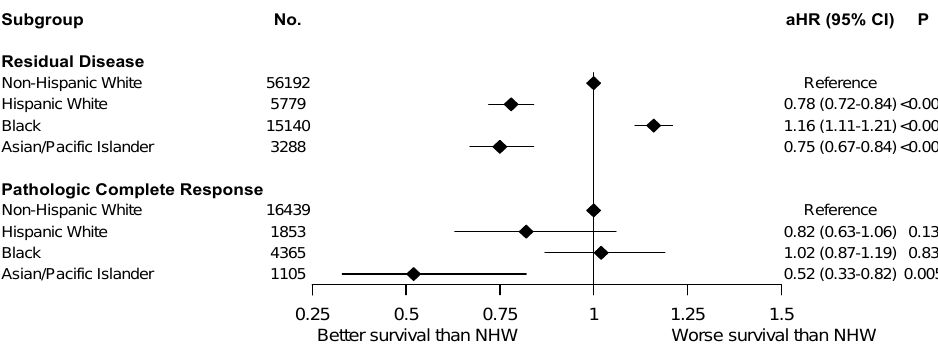
Figure 3. Cox regression multivariable analysis for overall survival stratified by pathologic responses and racial groups. No.: number; aHR: adjusted hazards ratio; 95% CI: 95% confidence interval; NHW: non-Hispanic White.